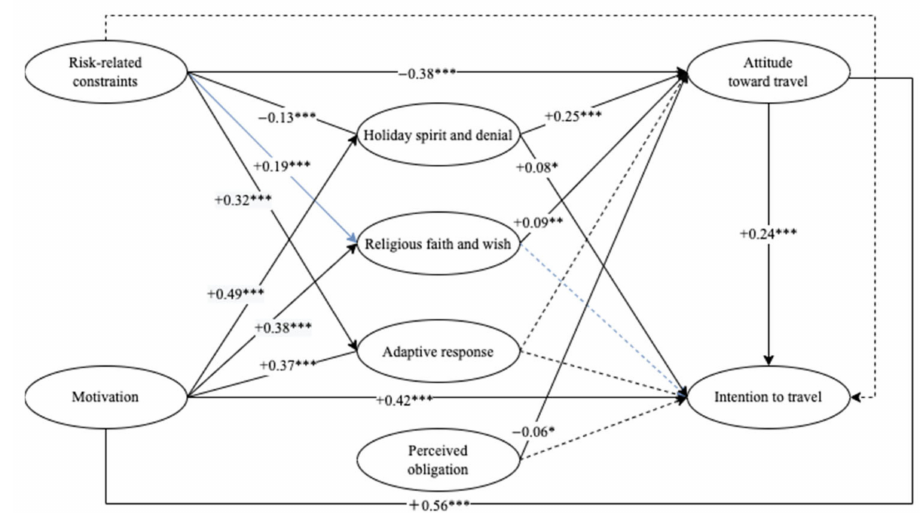
Figure 3. Results of hypothesis model (Round 2). Note: * p < 0.1, ** p < 0.05, *** p <